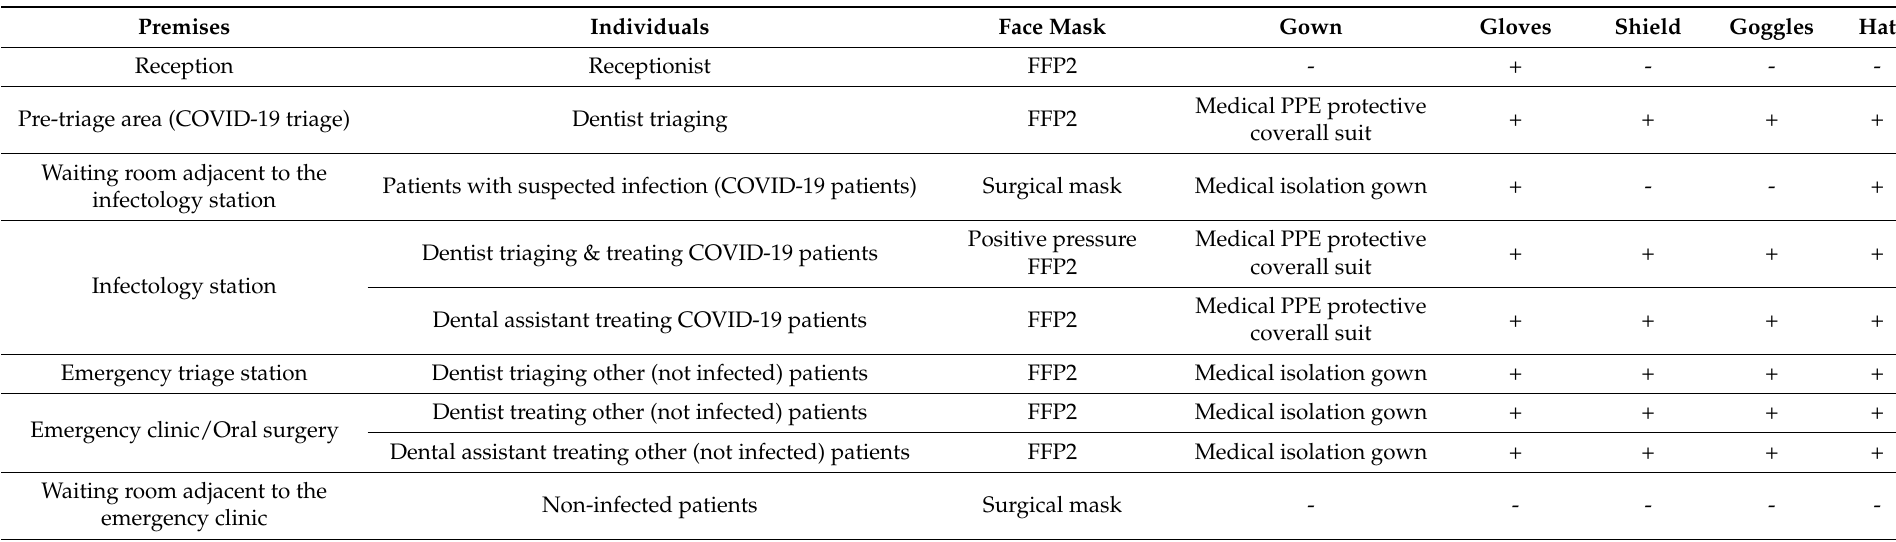
Table 1. Internal regulations on protective equipment in the Department of Community Dentistry of Semmelweis